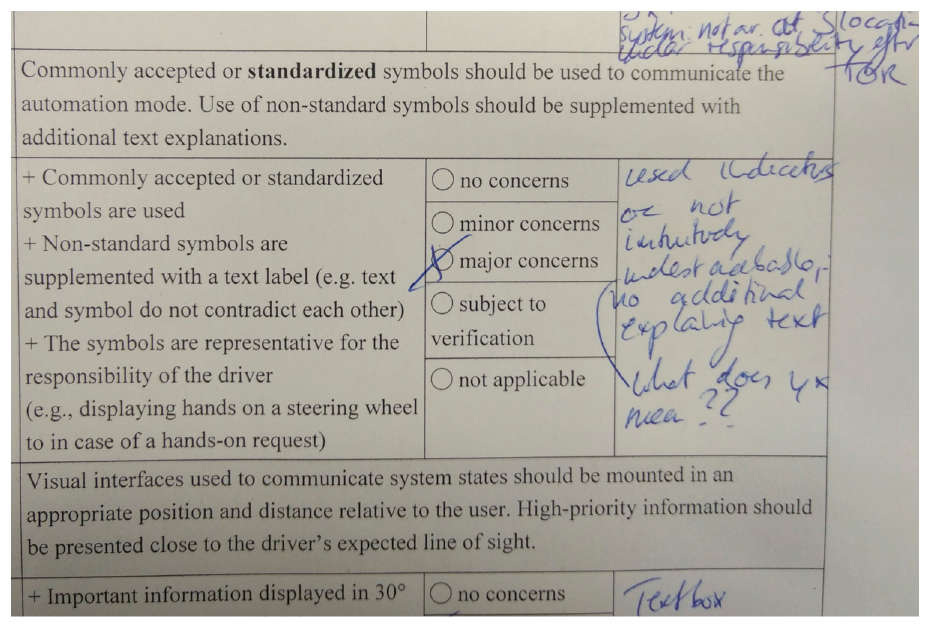
Figure 3. Example of the format of the checklist and an evaluated item.